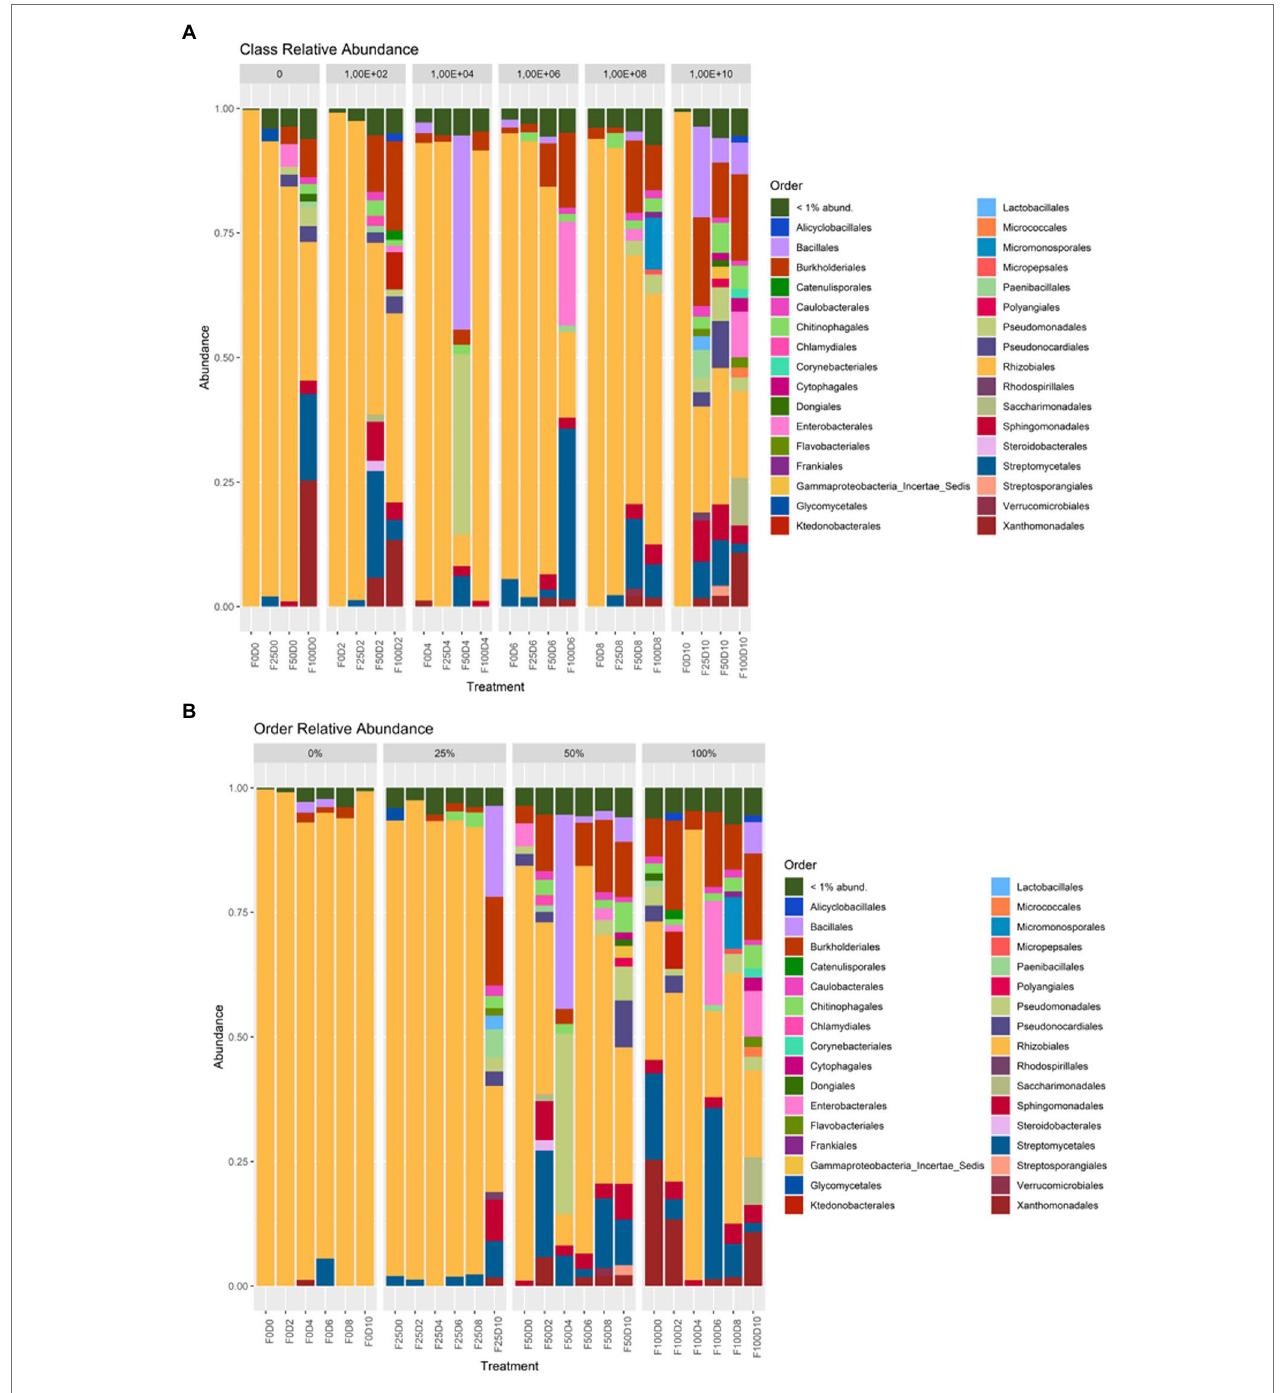
FIGURE 6 | Taxonomic affiliation at the order level regarding inoculation (A) and fertilization (B)